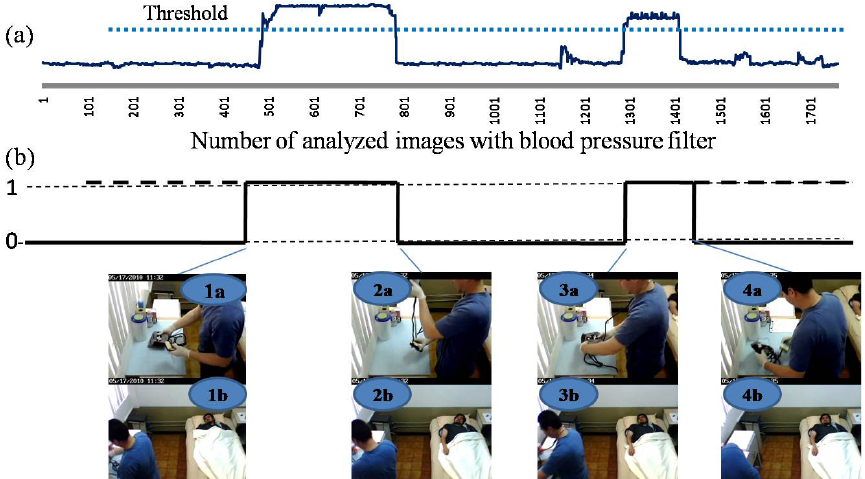
Figure 8. Images correlation results using blood pressure filter ( a ) Correlation values obtained from analyzes a video sequence, raw data; ( b ) Data